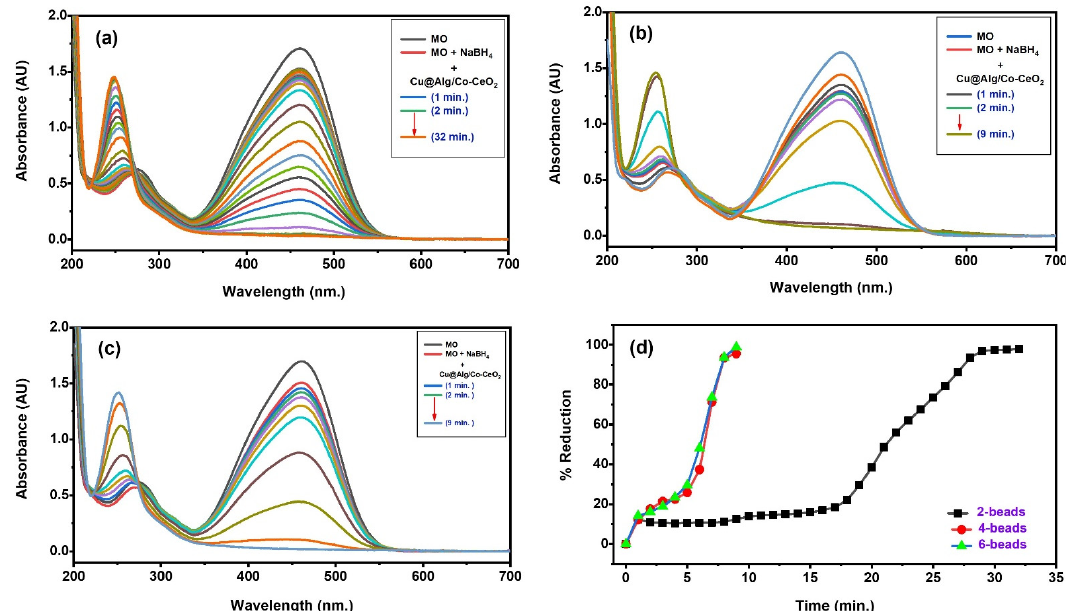
Figure 5. UV–vis absorption spectra for the reduction of MO (0.07 mM) using 0.25 mL NaBH 4 (0.1 M) and ( a ) 2 beads, ( b ) 4 beads, and ( c ) 6 beads of Cu@Alg/Co–CeO 2 catalyst. ( d ) % Reduction of MO as a function of time.